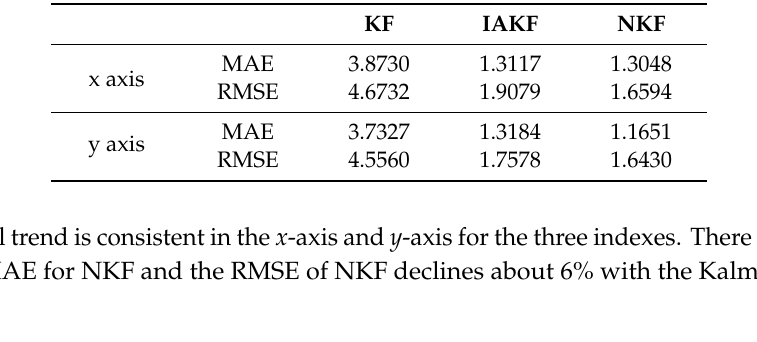
Table 2. Evaluation of filtering errors (whole trajectory).